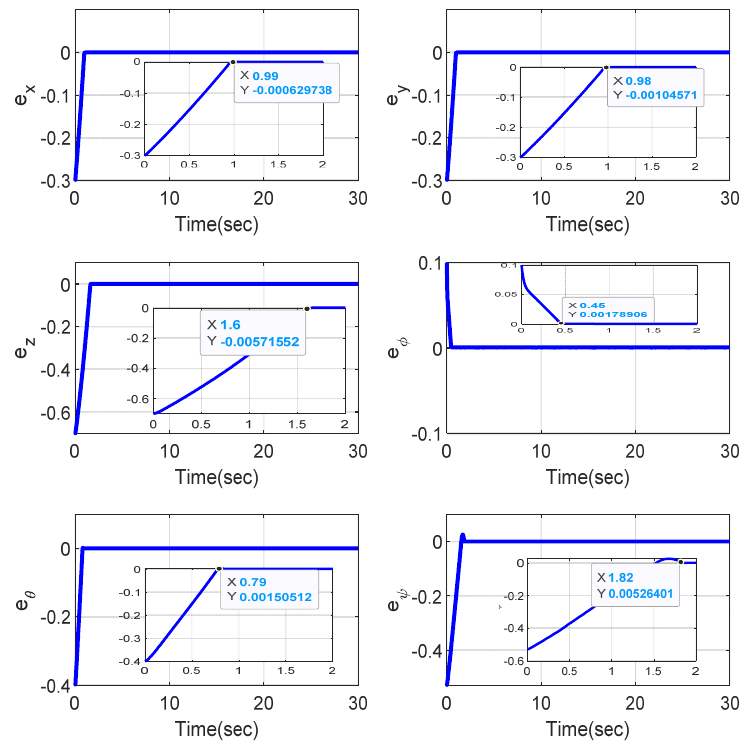
Figure 4. Trajectory of the tracking errors.